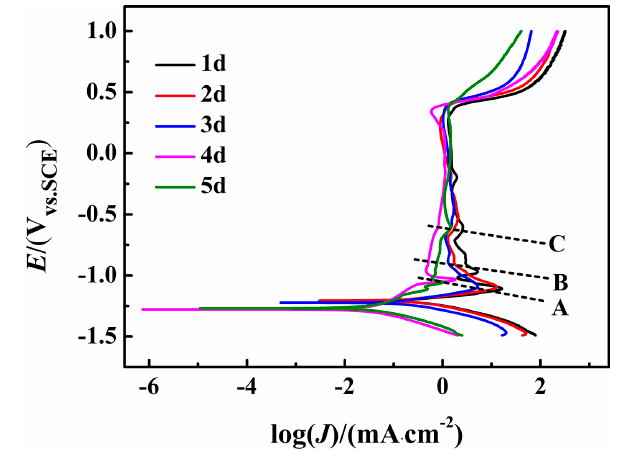
Figure 5. Polarization curves of 12Cr1MoV steel corroded in the TCSA solution for different times (1 d, 2 d, 3 d, 4 d, or 5 d) at 55 °C.